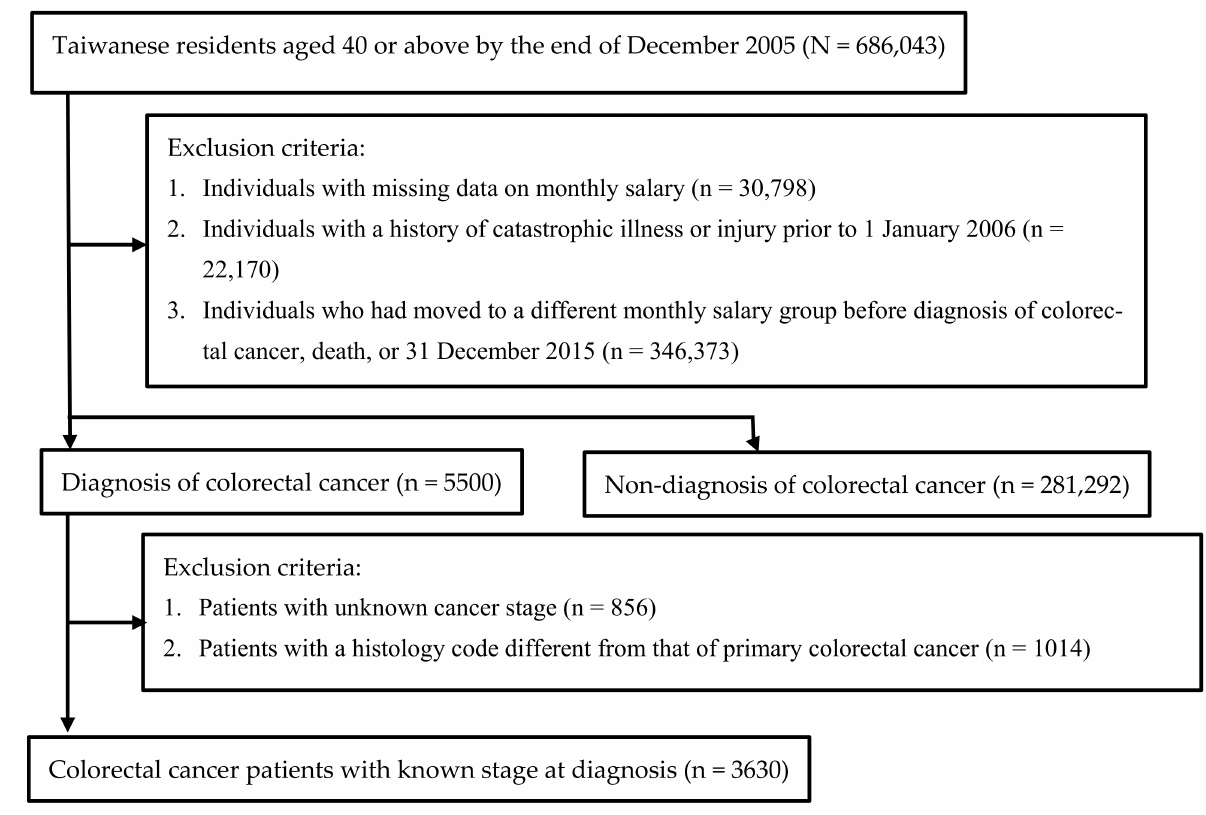
Figure 1. Selection process of study